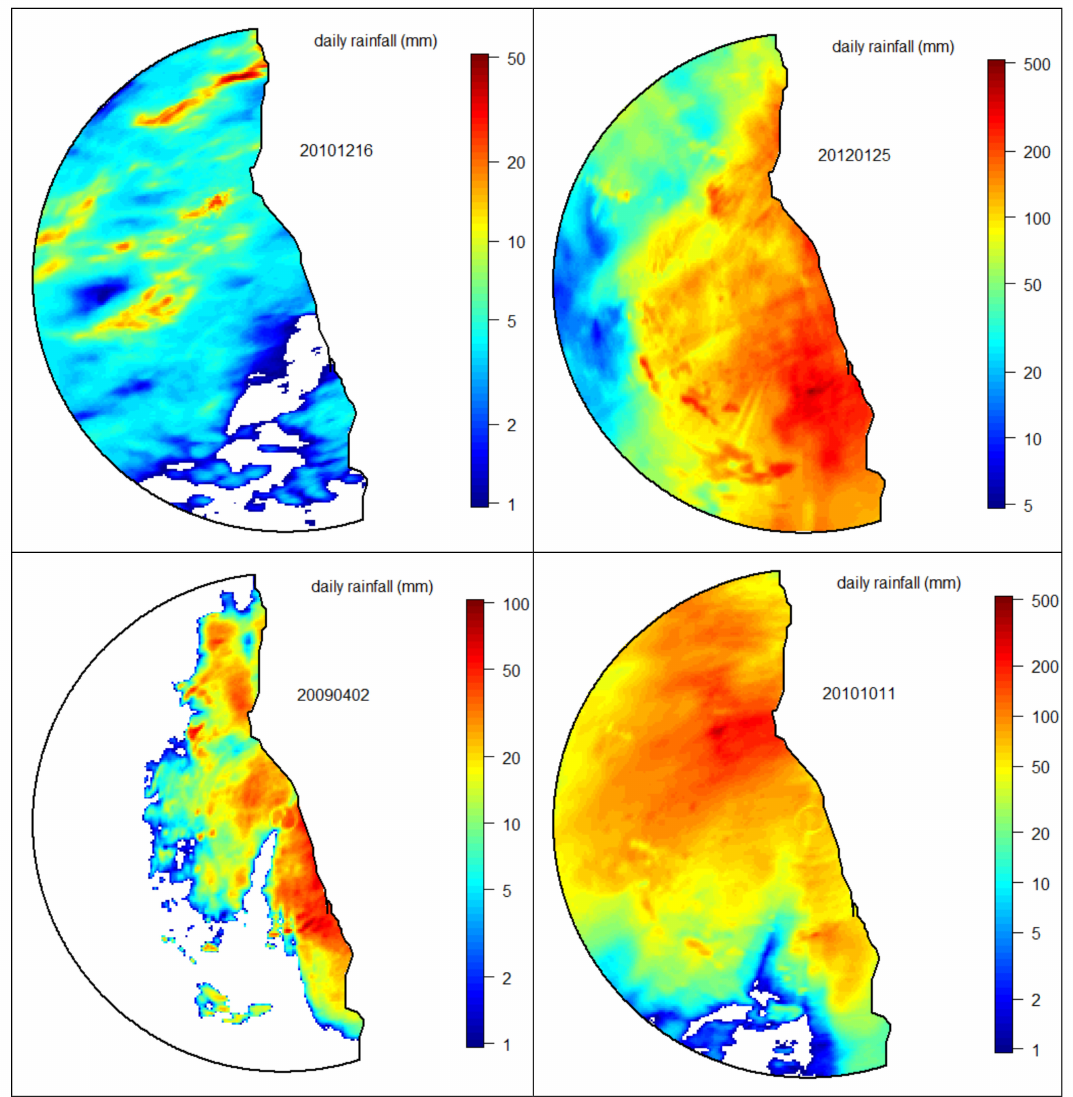
Figure 5. Radar daily rainfall images after bias correction of some wet days exhibiting di ff erent statistical